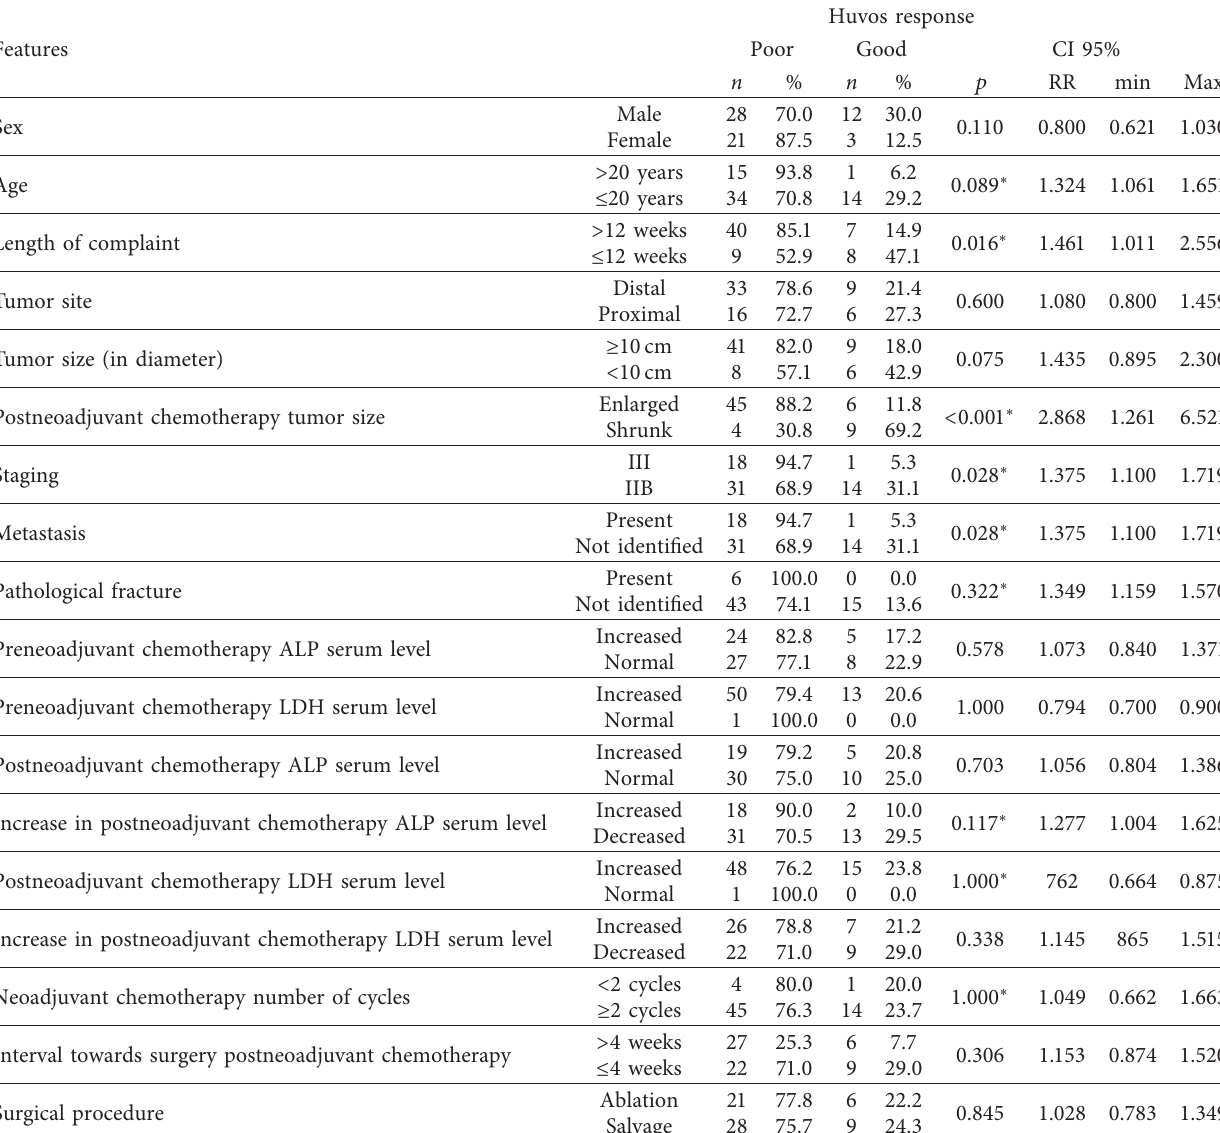
Table 2: Univariate analysis of clinical features and laboratory parameters with histopathological response based on Huvos grading system. Features